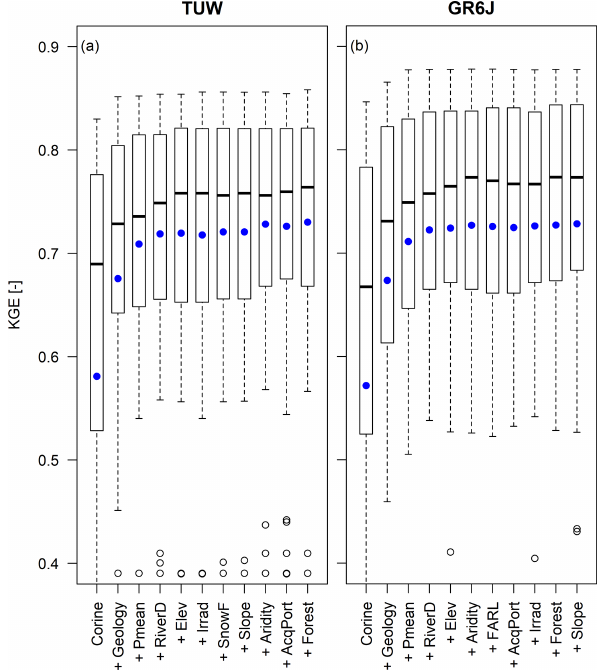
Figure A1. Kling–Gupta efficiencies for the TUW (a) and GR6J (b) models for the consecutive steps of the similarity analysis. Boxes refer to 25% and 75% quantiles, whiskers refer to 10% and 90% quantiles and the blue points to the